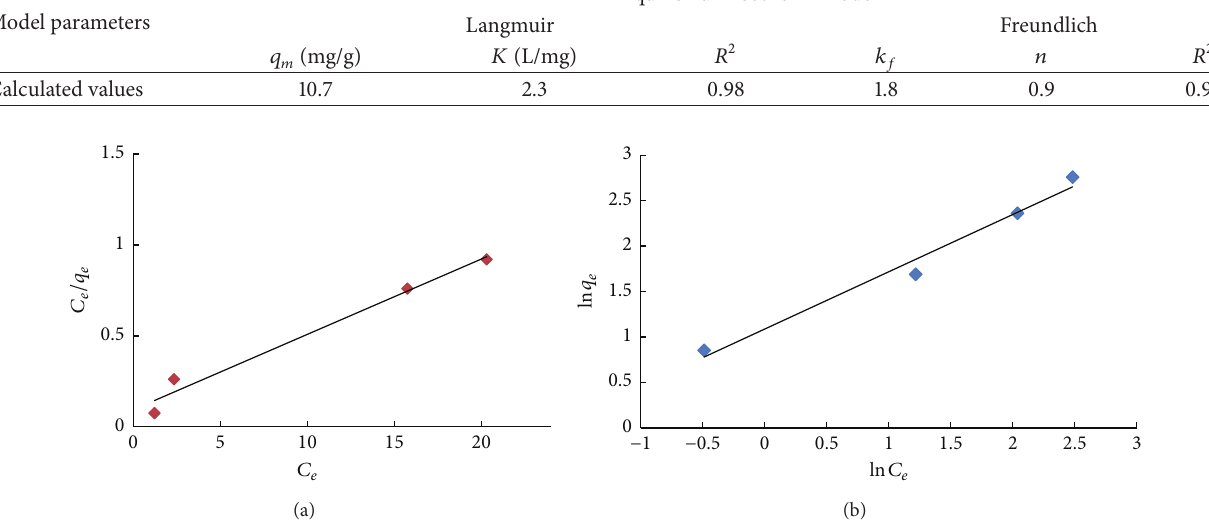
Figure 7: Equilibrium modeling of basic violet 16 sorption onto composite sheet matrix at various initial dye solution concentrations: (a) Langmuir; (b)